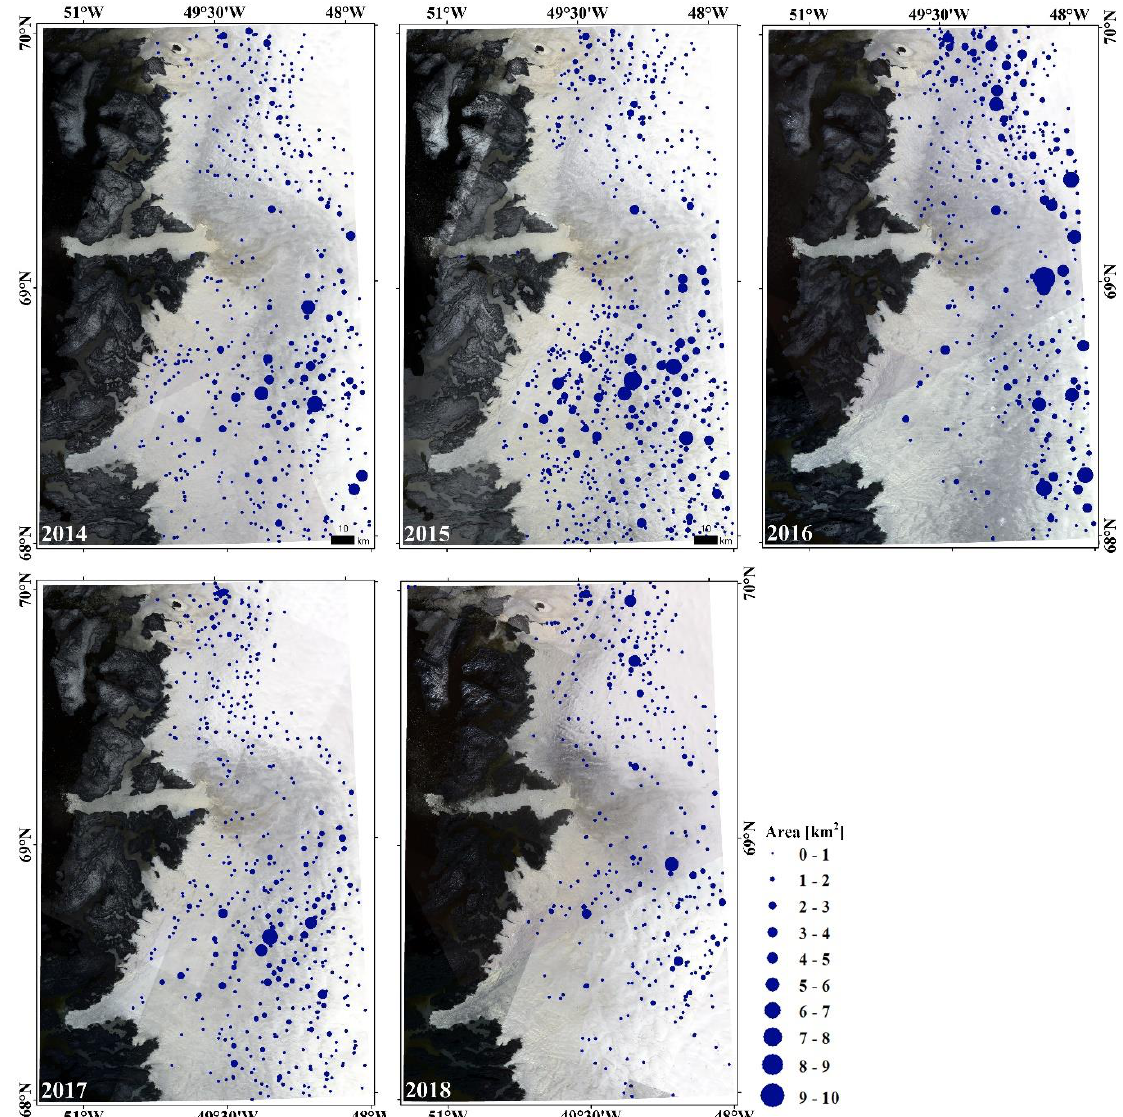
Figure 11. SGLs extraction results from 2014 to 2018.